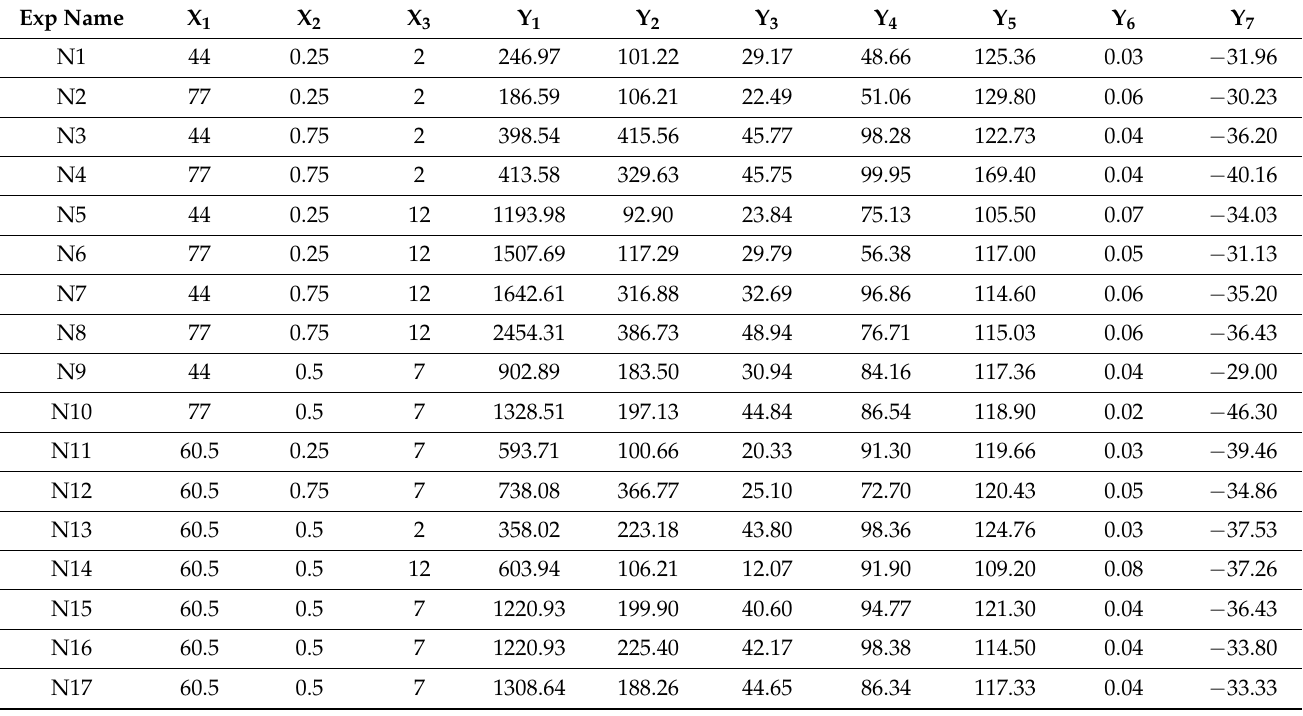
Table 1. The formulations and the experimental results of the optimization DoE.